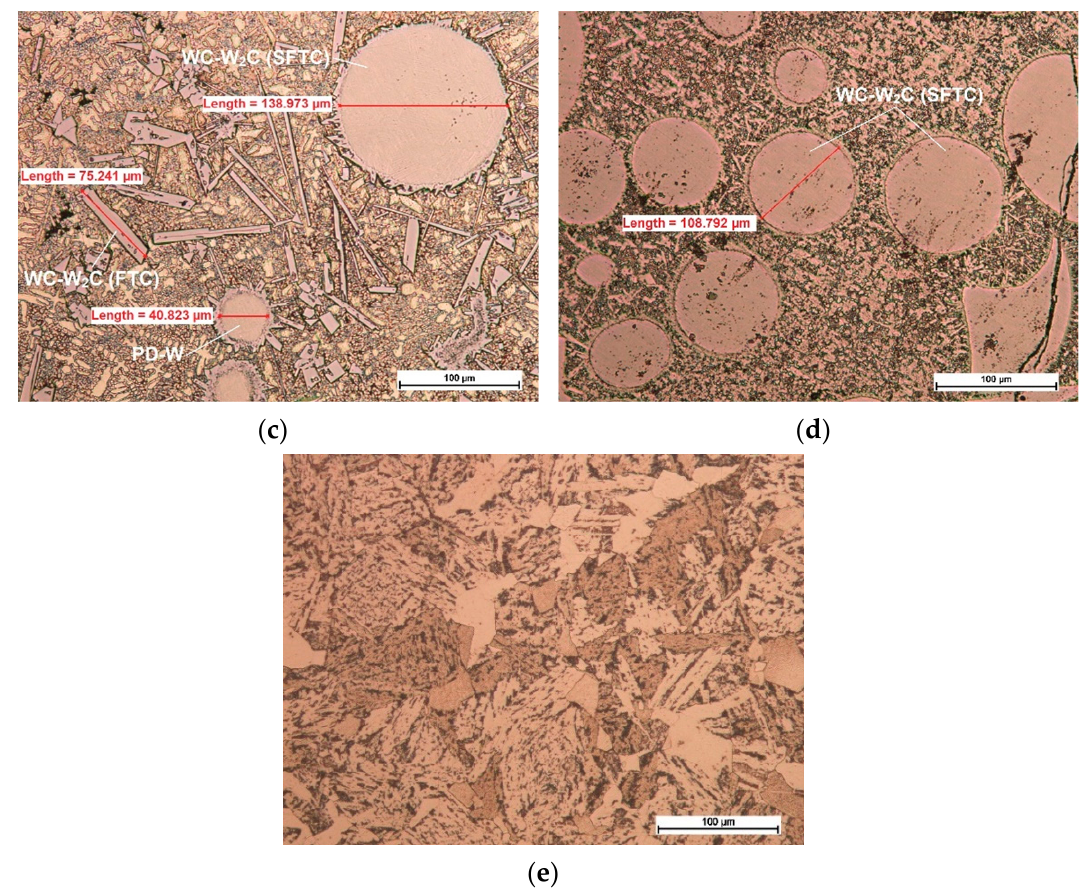
Figure 6. Light microscopy image of the structure of the composite layer padded using the PPTAW method with powder on the alloy matrix: ( a ) cobalt with a hard reinforcing phase in the form of crushed TiC and spherical PD-W particles (C1 filler material); ( b ) nickel with a hard reinforcing phase in the form of crushed TiC and spherical broken tungsten carbide WC-W2C particles (C2 filler material); ( c ) nickel with a hard reinforcing phase in the form of particles of WC-W 2 C spherical and broken tungsten carbide and spherical polycrystalline synthetic diamond (C3 filler material); ( d ) nickel with a hard reinforcing phase in particles of spherical tungsten carbide WC-W 2 C and titanium diboride TiB 2 (C4 filler material); ( e ) microstructure of the parent material of AISI 4715 non-alloy structural steel.